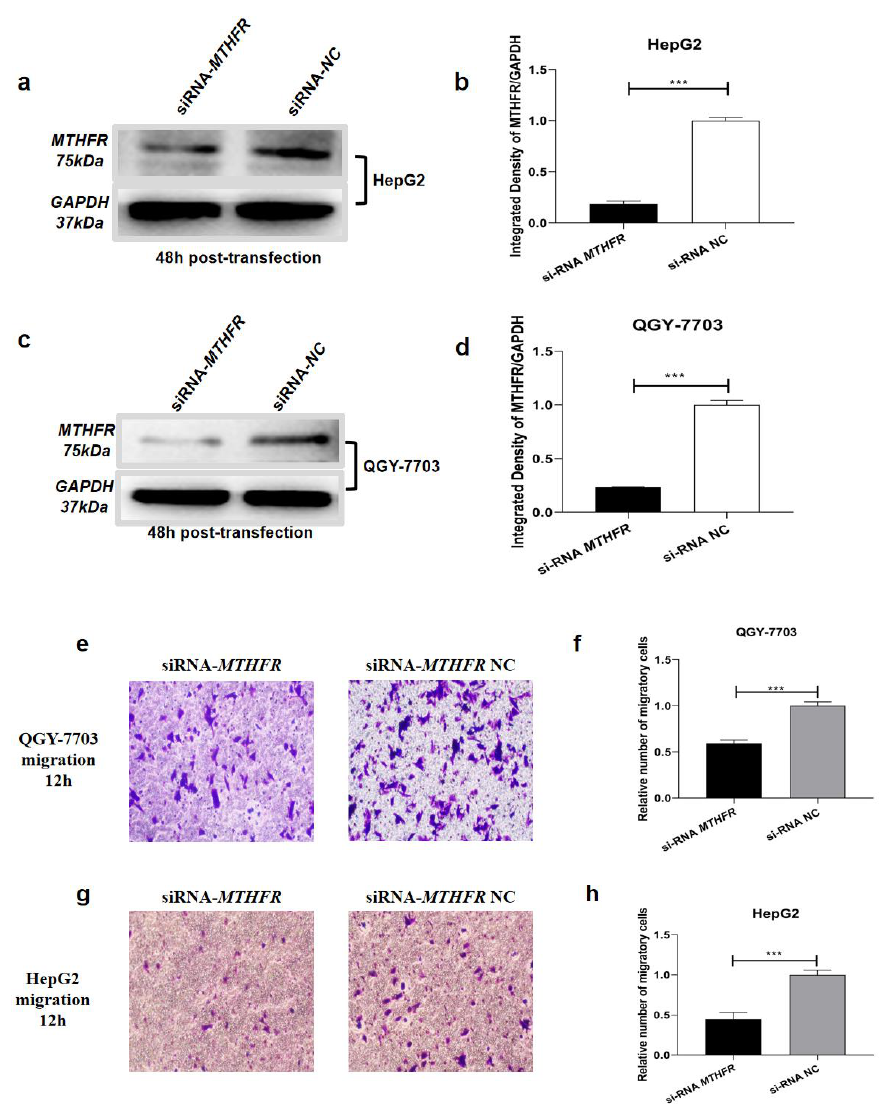
Figure 6. Western blot assays showed the relative protein expression of MTHFR in QGY-7703 and HepG2 cells after the transfection of ectopic expression of siRNA-MTHFR and siRNA-NC ( a – d ); representative images ( e , g ) and bar graphs ( f , h ) depicting the migration ability of QGY-7703 and HepG2 after siRNA-MTHFR (100 nM) and siRNA NC (100 nM). Data are presented as mean ± S.D. ( n = 6) and analyzed by a two-tailed unpaired t -test (×200 magnification, *** p < 0.001).